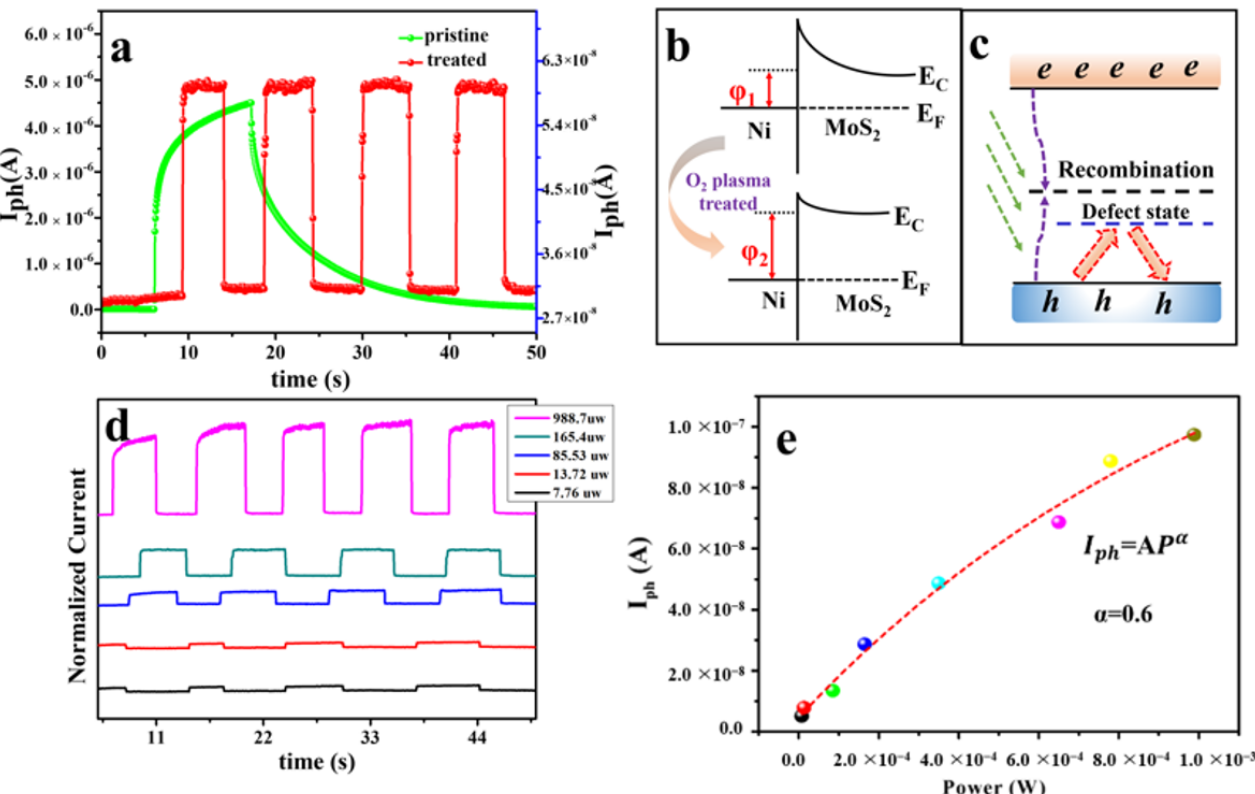
Figure 3. ( a ) Transient response of as-prepared and plasma treated MoS 2 . ( b ) Energy band diagrams of Ni/MoS 2 junctions before (top) and after (bottom) O 2 plasma treatment of few layer MoS 2 . ( c ) Schematic diagram of the band structure of the treated MoS 2 , different to pristine MoS 2 , the deep trap states are filled with oxygen molecules, only leaving shallow defect traps. ( d ) The temporal time-dependent light current ( I ph ) under laser illumination with a different laser power. ( e ) The relationship between the I ph and the laser power, and it can be fitted by I ph = AP α , where α is estimated to be